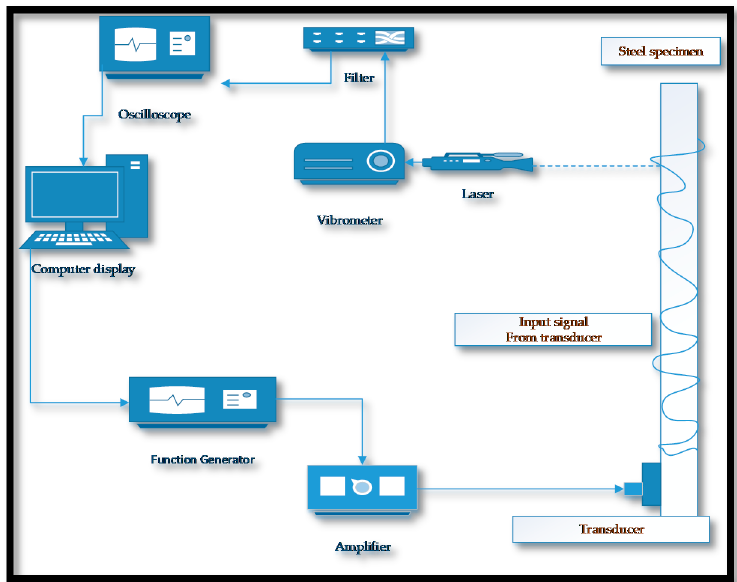
Figure 10. Experimental setup for laser measurement of UGWs on steel specimen using a partial non-contact method.